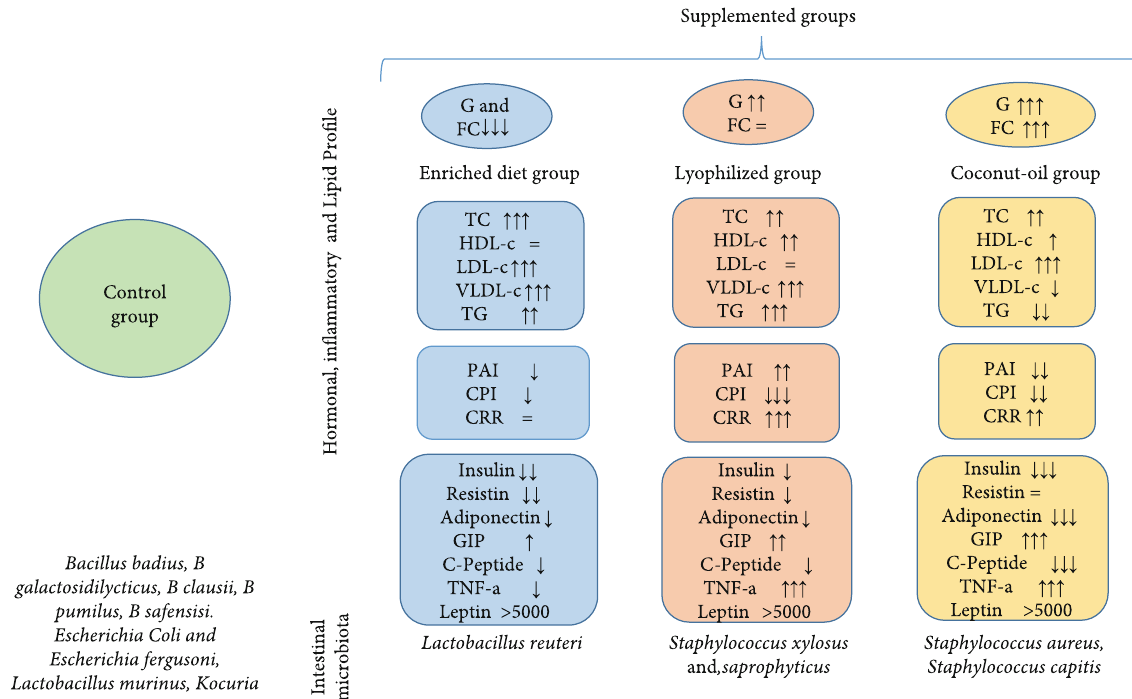
Figure 4: The scheme summarizes and compares the results of metabolic pro fi le and microbiota content of the small intestine in mice supplemented or not for 8 weeks. The enriched diet reduces signi fi cantly the hormonal pro fi le, with changes in lipid pro fi le and a signi fi cant reduction in TNF- α and C-peptide. EPA and DHA administered in lyophilized form induced a higher secretion of TNF- α and an increase in atherogenic index and cardio risk ratio, with an increased lipid pro fi le, causing metabolic and in fl ammatory alterations. Coconut oil moderately increased the lipid pro fi le and reduced C-peptide and hormonal secretion with the exception of GIP, with a signi fi cant increase in TNF- α . PAI: plasma atherogenic index; CPI: cardioprotective index; CRR: cardiac risk ratio; GIP: gastric inhibitory polypeptide; HDL-c: high-density lipoprotein cholesterol; LDL-c: low-density lipoprotein cholesterol; TC: total cholesterol; TG: triacylglycerides; TNF- α : tumor necrosis factor-alpha; VLDL-c: very low-density lipoprotein cholesterol; G: glycaemia; FC: food